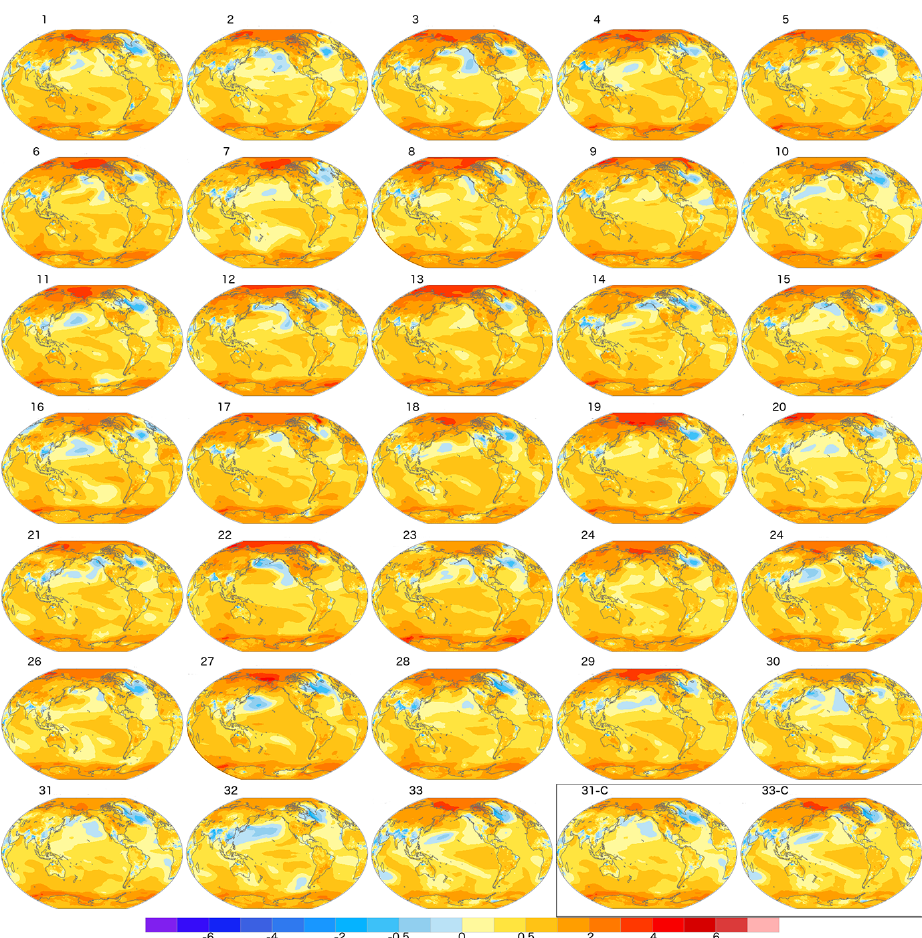
Figure 1. CVDP-generated global maps of historical (1920–2012) annual surface air temperature trends for the 30 original individual CESM- LE ensembles member, the three new members (31–33), and the reconstructed data from new members 31 and 33 (contained in the lower right